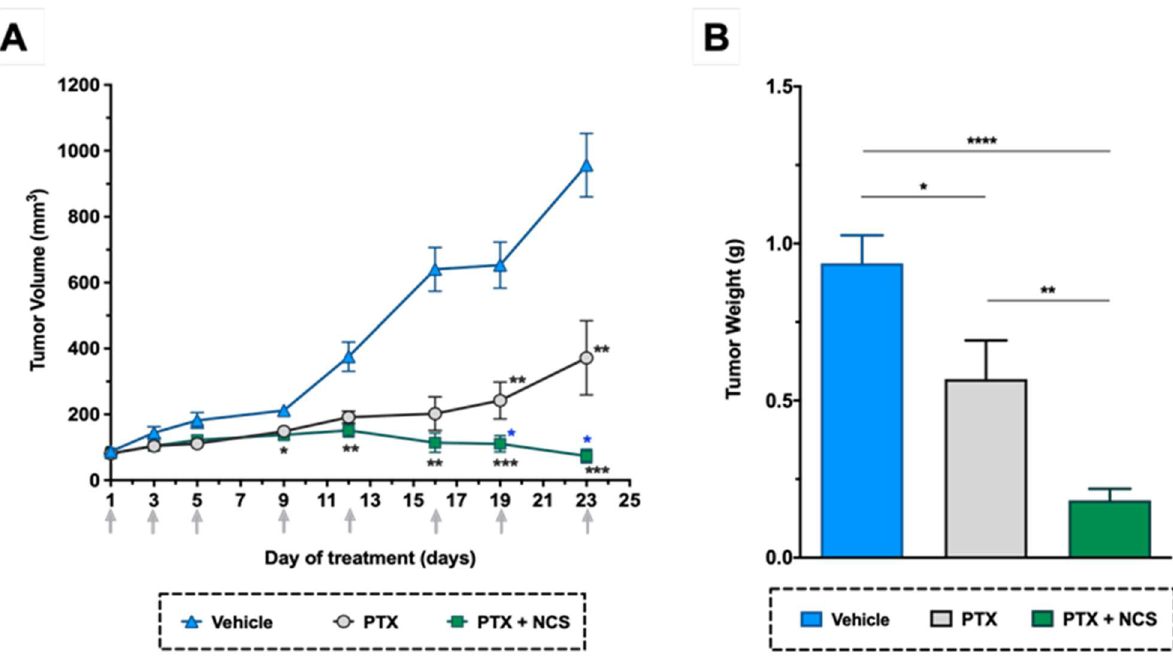
Figure 9 . In vivo efficacy of PTX in combination with NCS in mice with orthotopic MDA-MB-231 tumors. ( A ) Tumor volume measurements in the study groups during treatment. ( B ) Tumor weights at the end of the experiment. Arrows indicate treatment points. The results are represented as the mean ± SEM in both graphs (animals/group ≥ 6). Statistic t-test analyses of combined treatment were performed in comparison with vehicle (black) as well as with PTX single treatment (blue). In all cases, * p < 0.05, ** p < 0.01, *** p < 0.001 and **** p < 0.0001.